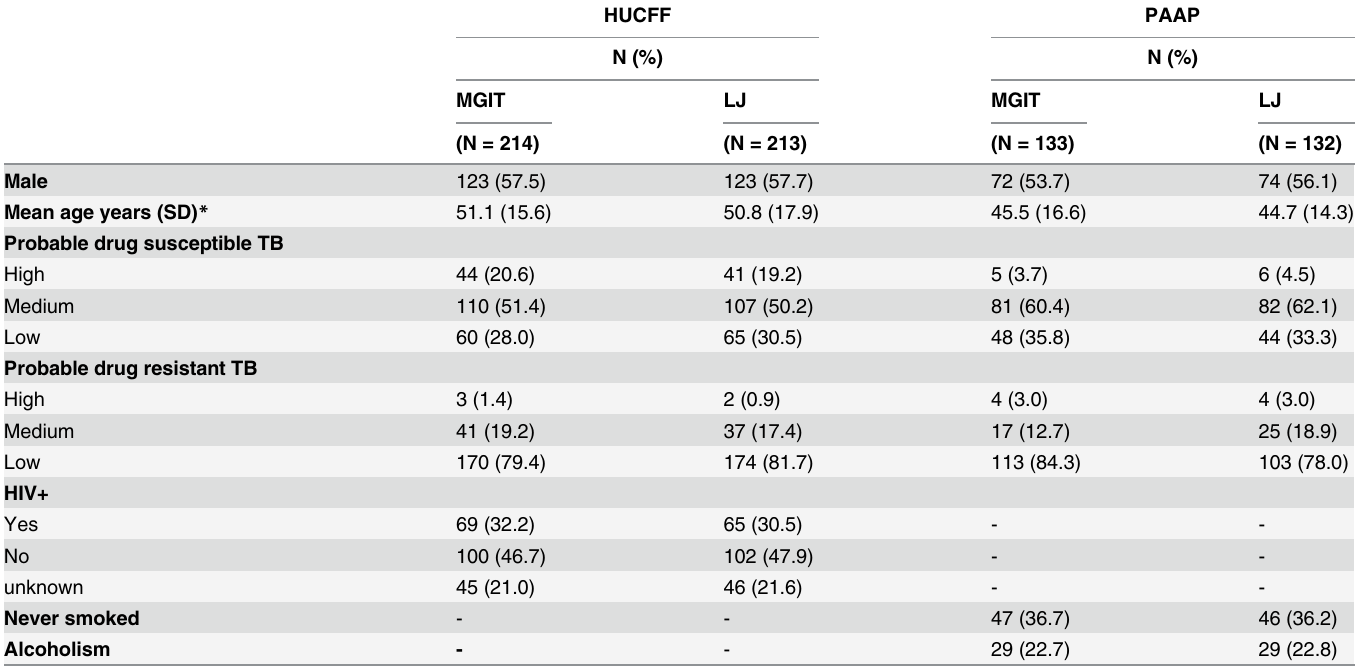
Table 1. Patient characteristics at study